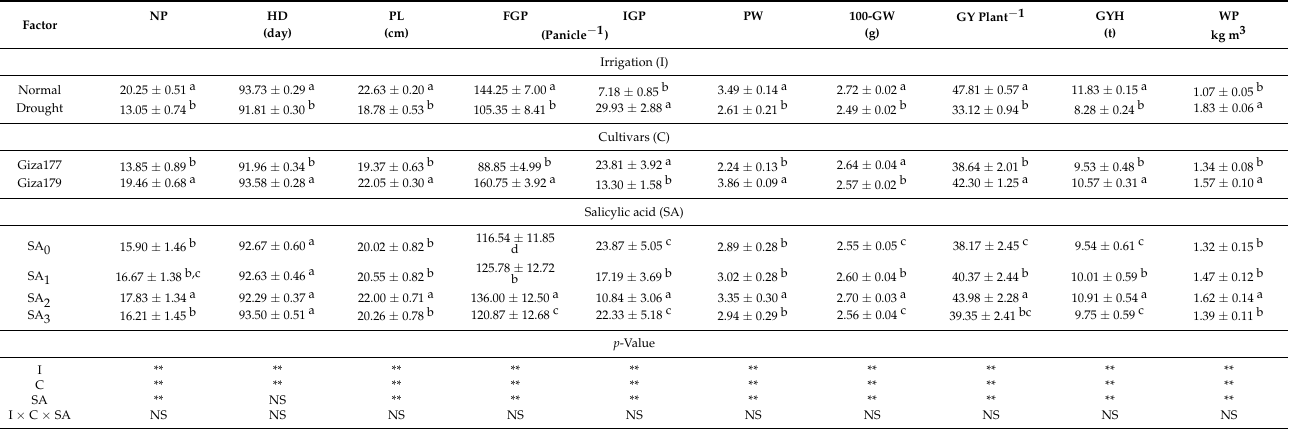
Table 6. Grain yield and its components traits of two rice cultivars (C) as affected by irrigation (I), salicylic acid (SA), and their